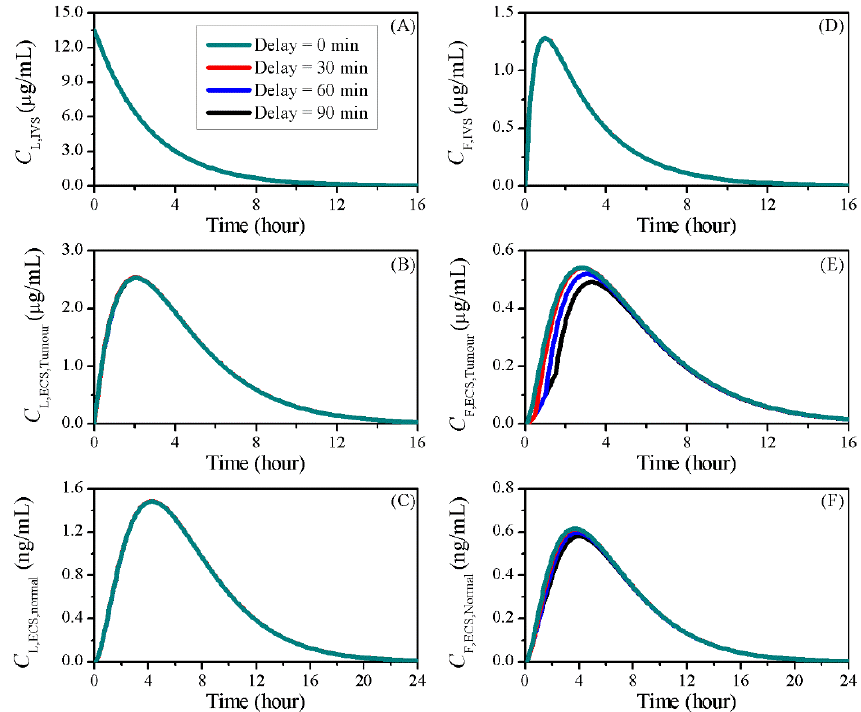
Figure 10. The time courses of doxorubicin concentrations in treatments with different BBBD timing. Liposome-encapsulated doxorubicin in ( A ) IVS, ( B ) tumour and ( C ) normal tissue ECS; free doxorubicin in ( D ) IVS, ( E ) tumour and ( F ) normal tissue ECS.